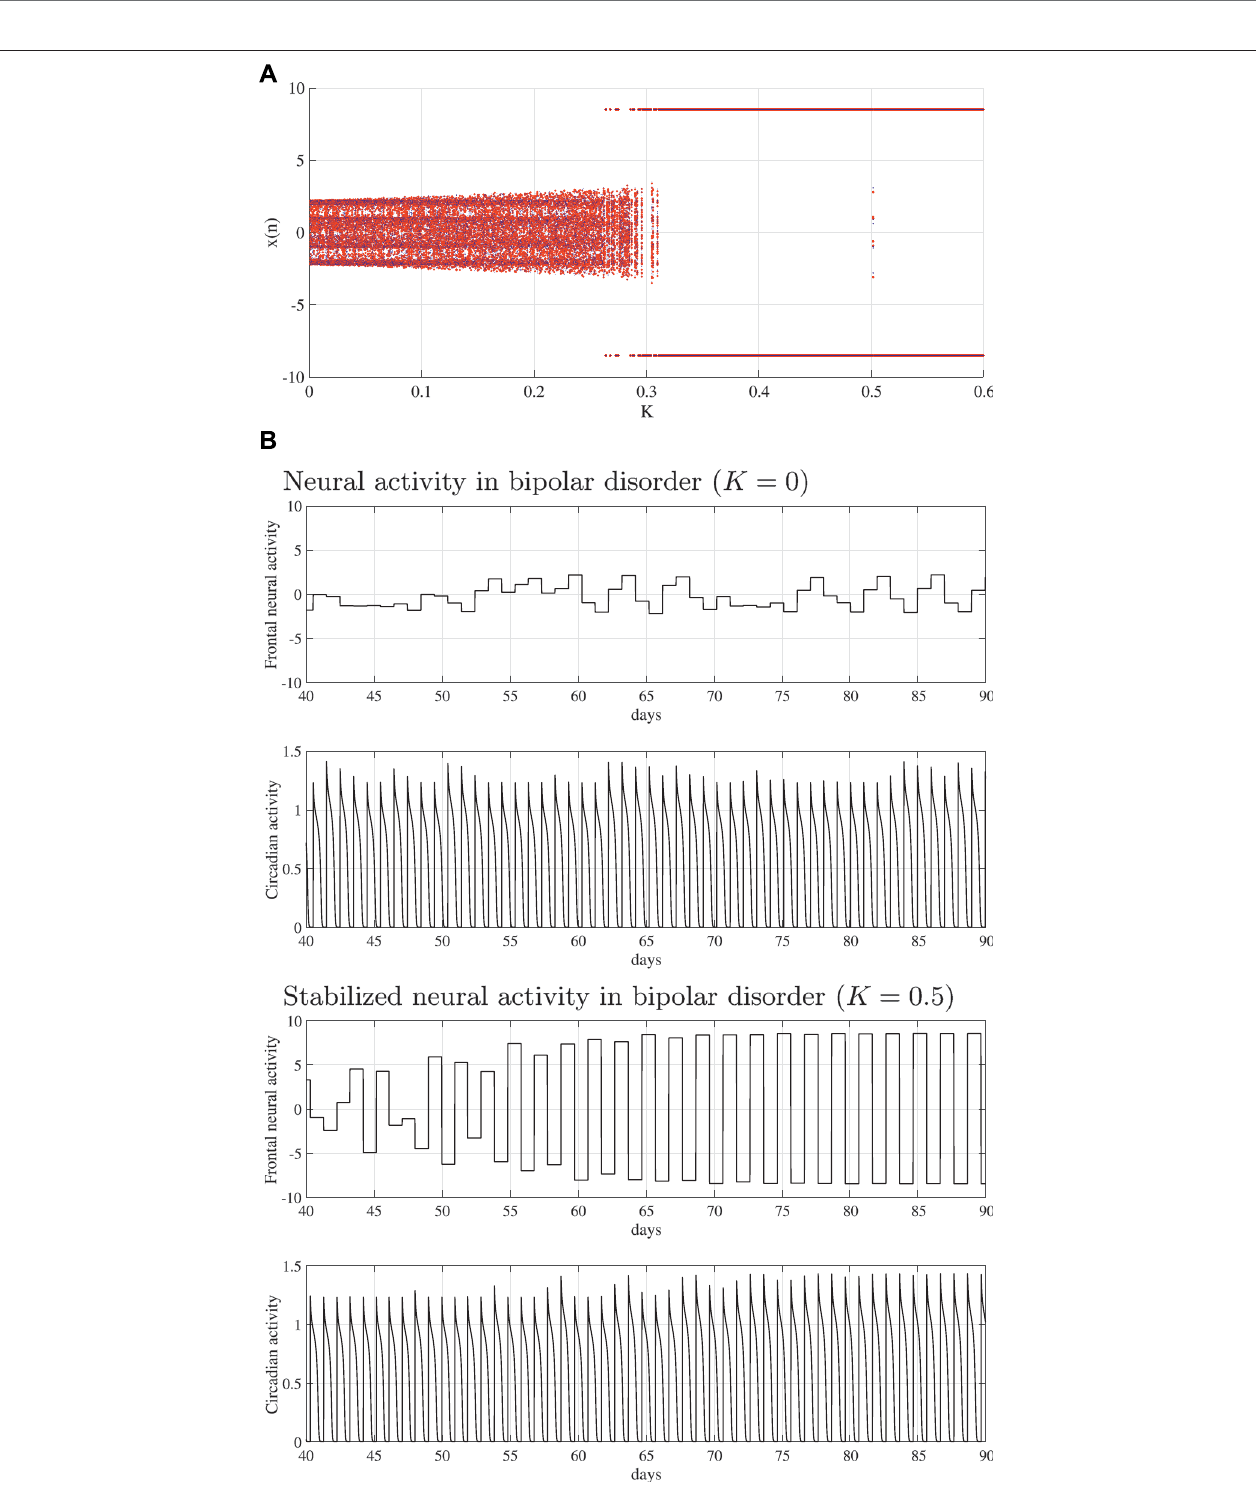
FIGURE4| Systembehaviorsintheneural systemcomposed ofthe frontalcortex and hypothalamusasafunctionofdelayedfeedbackstrength K . (A) Bifurcation diagram of the frontal neural activity x ( n ) given by Eq. (10) as a function of K . Blue and red dots indicate the positive and negative initial value x (0) cases, respectively. (B) Time-seriesofthefrontalneuralactivity x ( n )andcircadianrhythmoutput( k )givenby Eq.(8) inthecaseswithoutfeedbacksignals (upperpanel) andthosewithfeedback signals (lower panel) . In K a 0 . 3, the chaos – chaos intermittent state transfers to the periodic state.